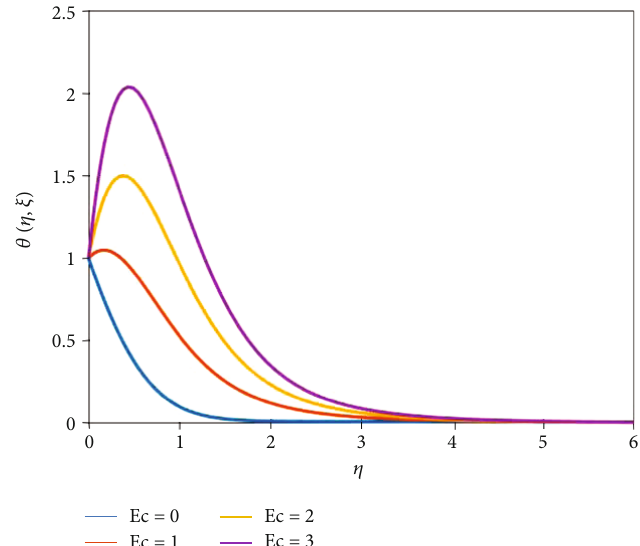
Figure 6: Temperature pro fi le for di ff erent values of N = NR = 0 : 2, Sc = 0 : 6, and Pr = 1 :